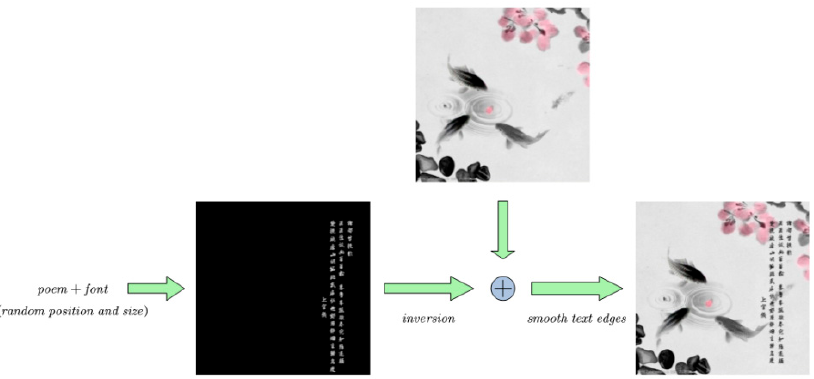
Figure 7. Generation of the simulation database.